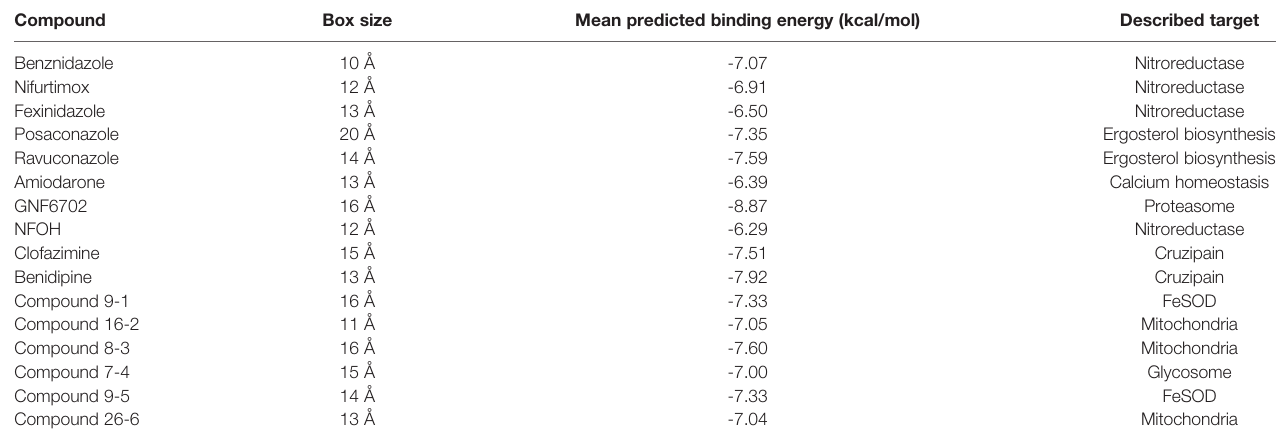
TABLE 1 | List of compounds used in this study. Compound Box size Mean predicted binding energy